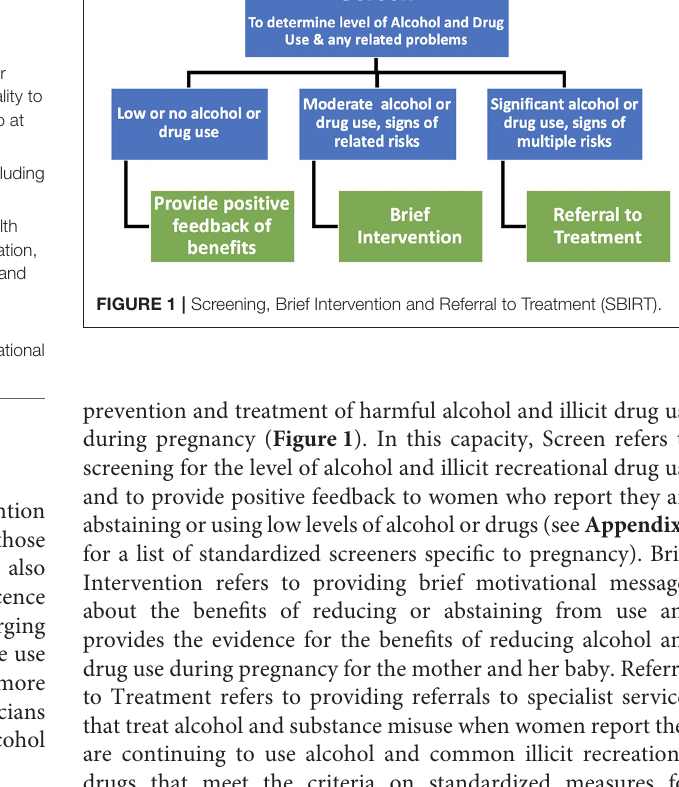
TABLE 1 | United Nations sustainable developmental goals for reproductive and child health.